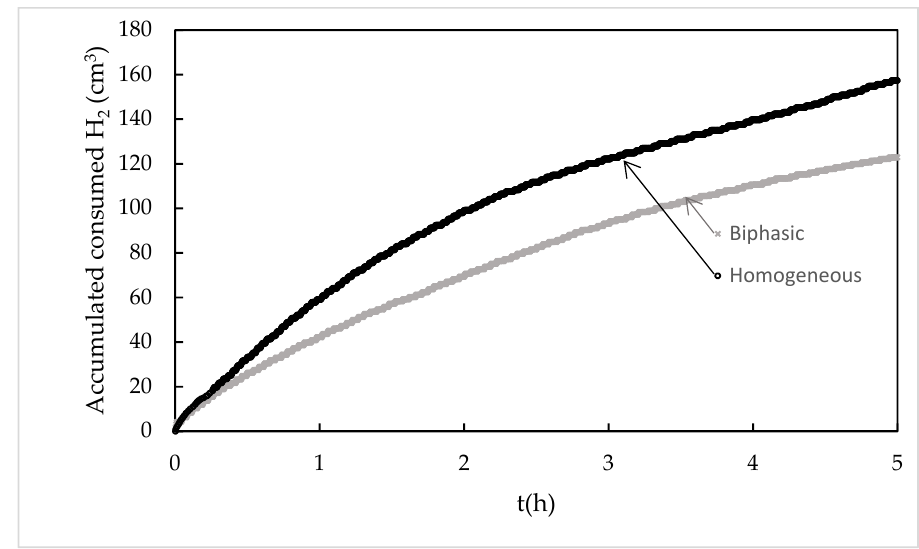
Figure 1. Hydrogen consumption versus time during CH hydrogenation in toluene (5% volume CH in toluene, 333 K, 10 bar H 2 ) with homogenous and biphasic systems.